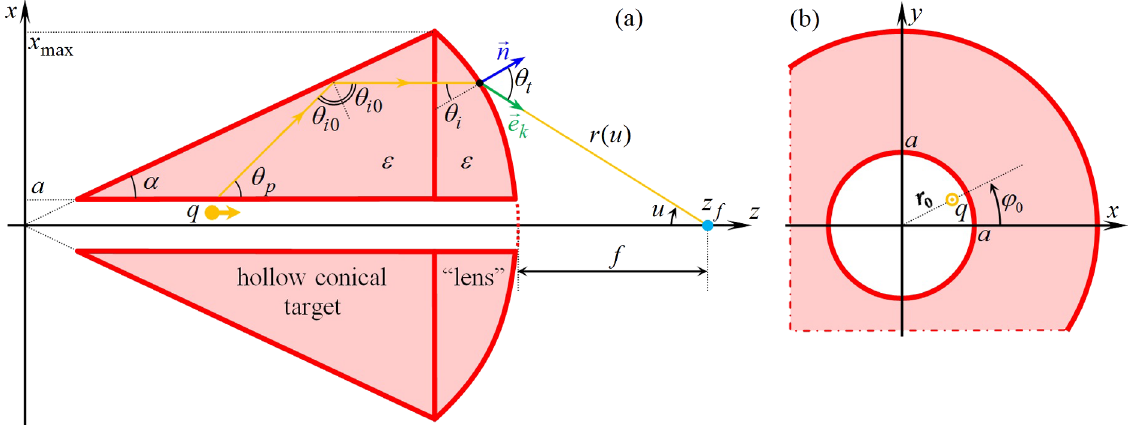
FIG. 1. Geometry of the problem and main notations. (a) ð zx Þ -cut of the “ axicon-based concentrator for CR ” : a hollow “ lens ” is attached to the output surface of a hollow conical target having its apex facing the incident charged particle bunch. Both revolution bodies are made from the same dielectric material with permittivity ε . The outer profile of the “ lens ” is hyperbolic and is determined by the function r ð u Þ . A point charge q moves along the straight trajectory shifted with respect to the z -axis. Depicted parameters are discussed in the text. (b) ð xy Þ -cut of the target (the channel radius is enlarged for convenience) and the position of the charge shifted